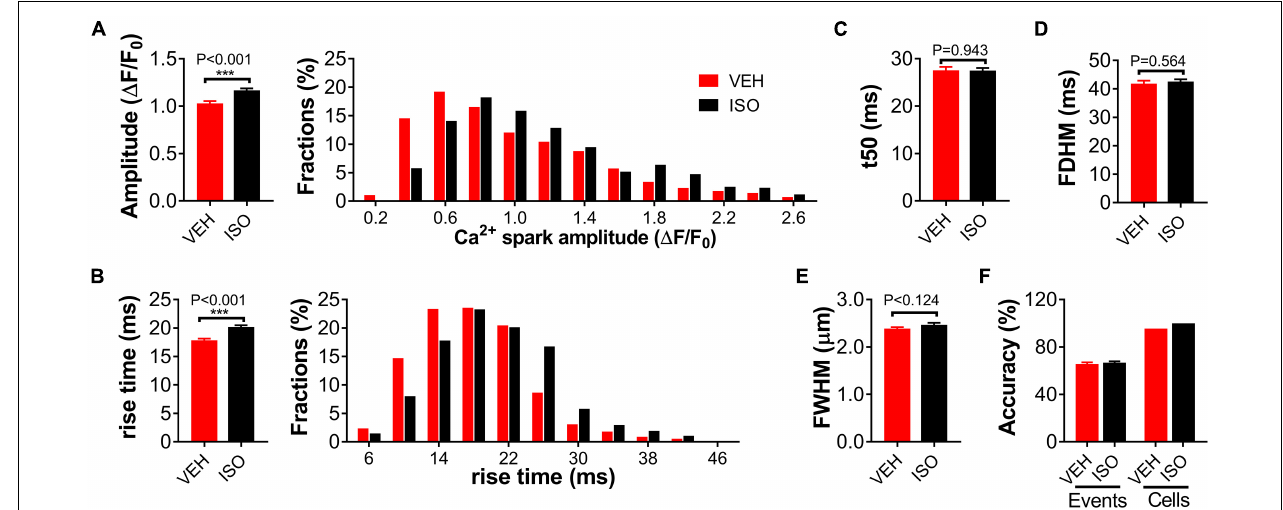
FIGURE 3 | Classification of single WT cardiomyocytes treated with isoprenaline or vehicle using Ca 2 + spark characteristics. Statistics and distributions of amplitude (A) and rise time (B) of Ca 2 + sparks in WT cardiomyocytes treated with 0.1- µ mol/L isoprenaline (ISO) or vehicle (VEH). These parameters show obviously different distributions between the two groups. Statistics of t 50 (C) , FDHM (D) , and FWHM (E) display no difference. n = 557 or 675 events from ≥ 20 cardiomyocytes per group. (F) Statistics of event and cell classification accuracy in the independent test dataset comprising 46 “VEH” and 20 “ISO” treated WT cardiomyocytes from at least five